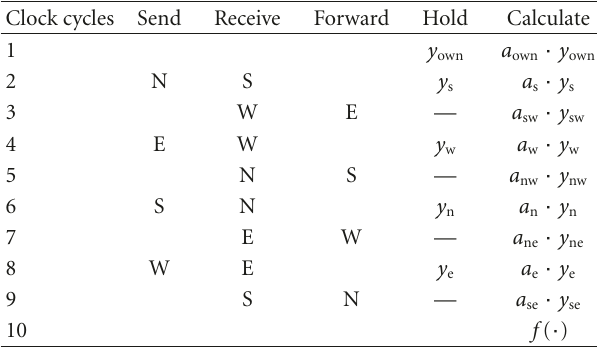
Table 2: The semiparallel broadcasting scheme interlaces compu- tation with communication. Characters N, E, S, and W stand for the four main directions on which packets are sent, received, or forwarded. The output value y sw , for example, originates from the southwest neighbor.